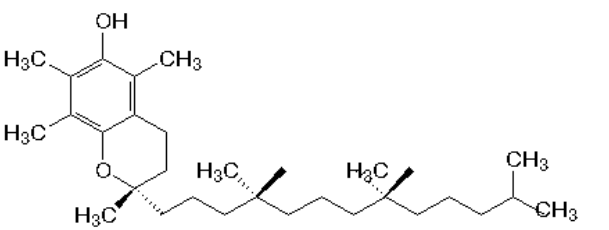
Figure 1. Chemical structure of α -tocopherol (AT).